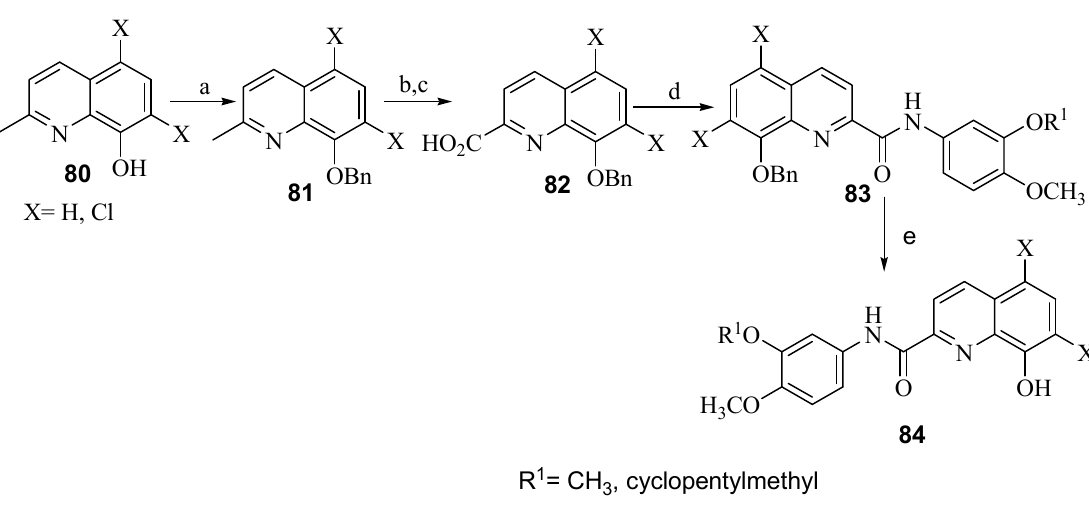
Scheme 19. Synthesis of new derivatives of 79 . Reagents: ( a ) (Boc) 2 O; ( b ) (i) substituted benzoic acid, SOCl 2 ; (ii) anhydrous CH 2 Cl 2 , TEA; ( c ) CH 2 Cl 2 :CH 3 OH ¼ 5:1, HCl (gas).